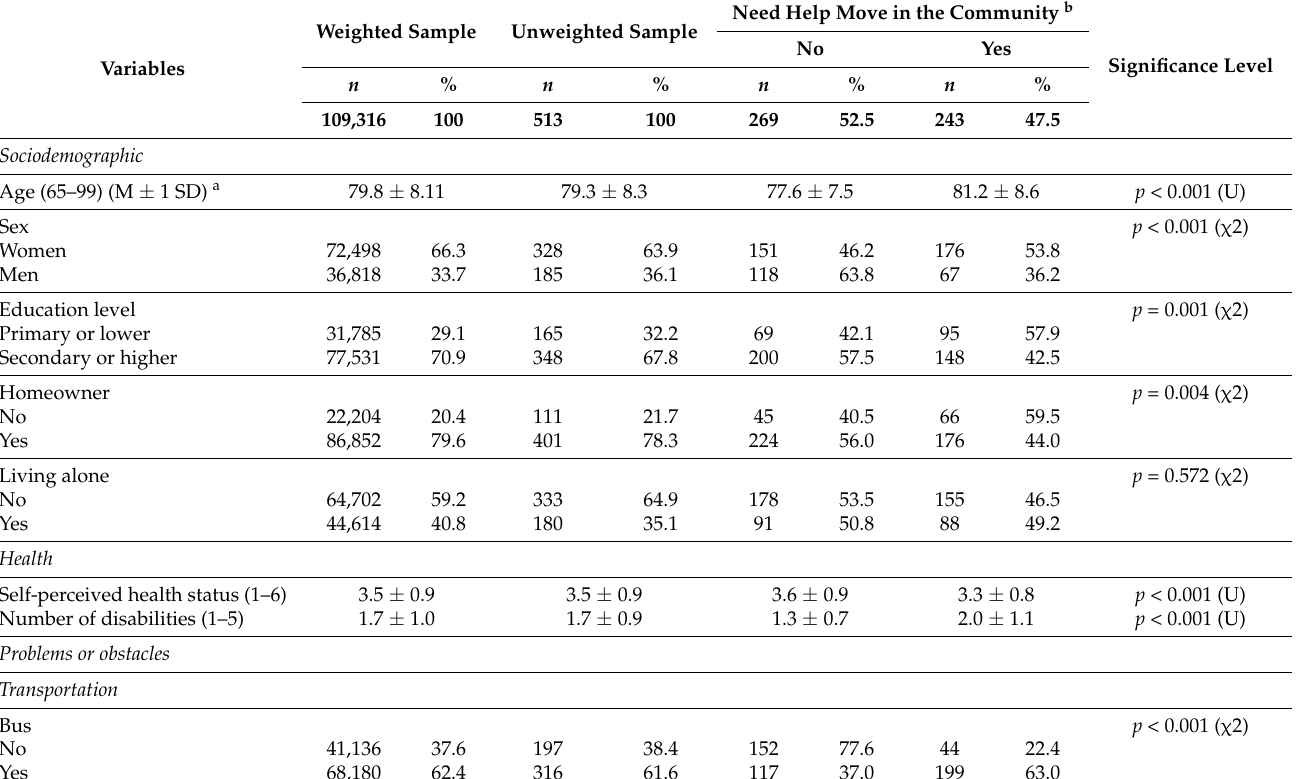
Table 1. Characteristics of the studied population of older adults with disability, and bivariate relations with the need for help to move in the